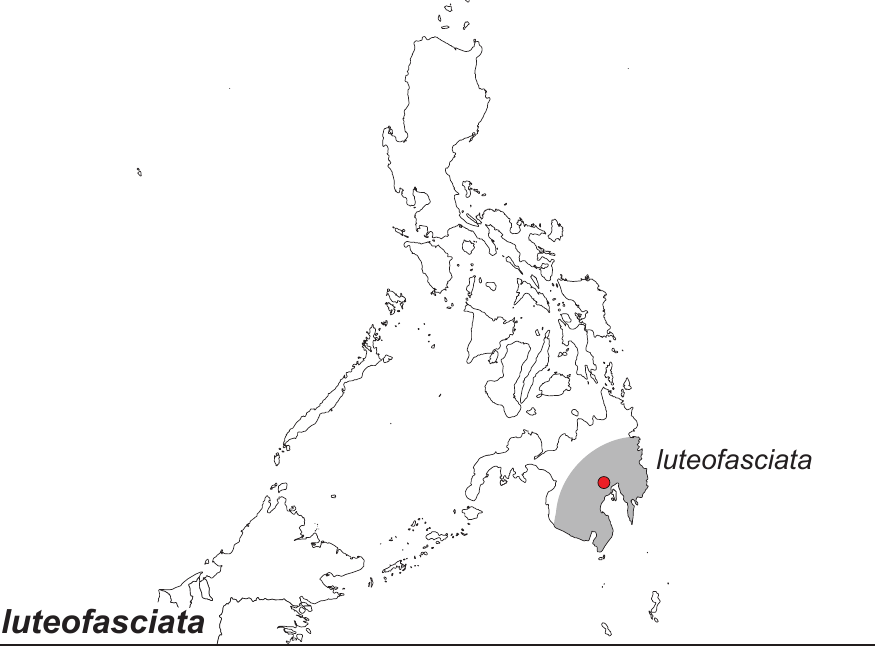
Figure 64. Distribution map of Elymnias luteofasciata